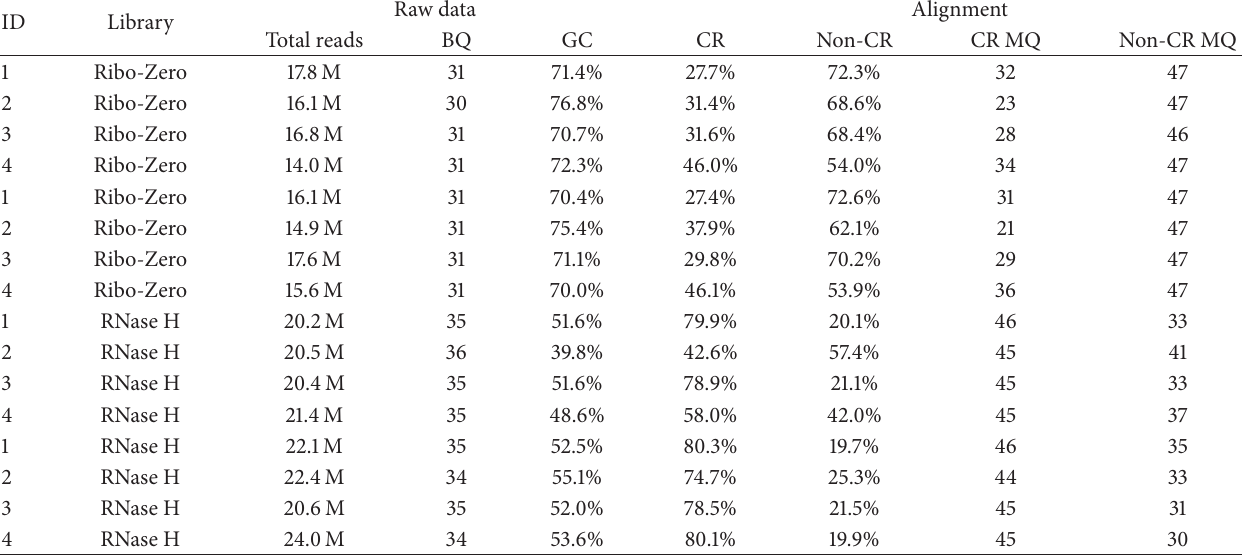
Table 1: Sample description and alignment